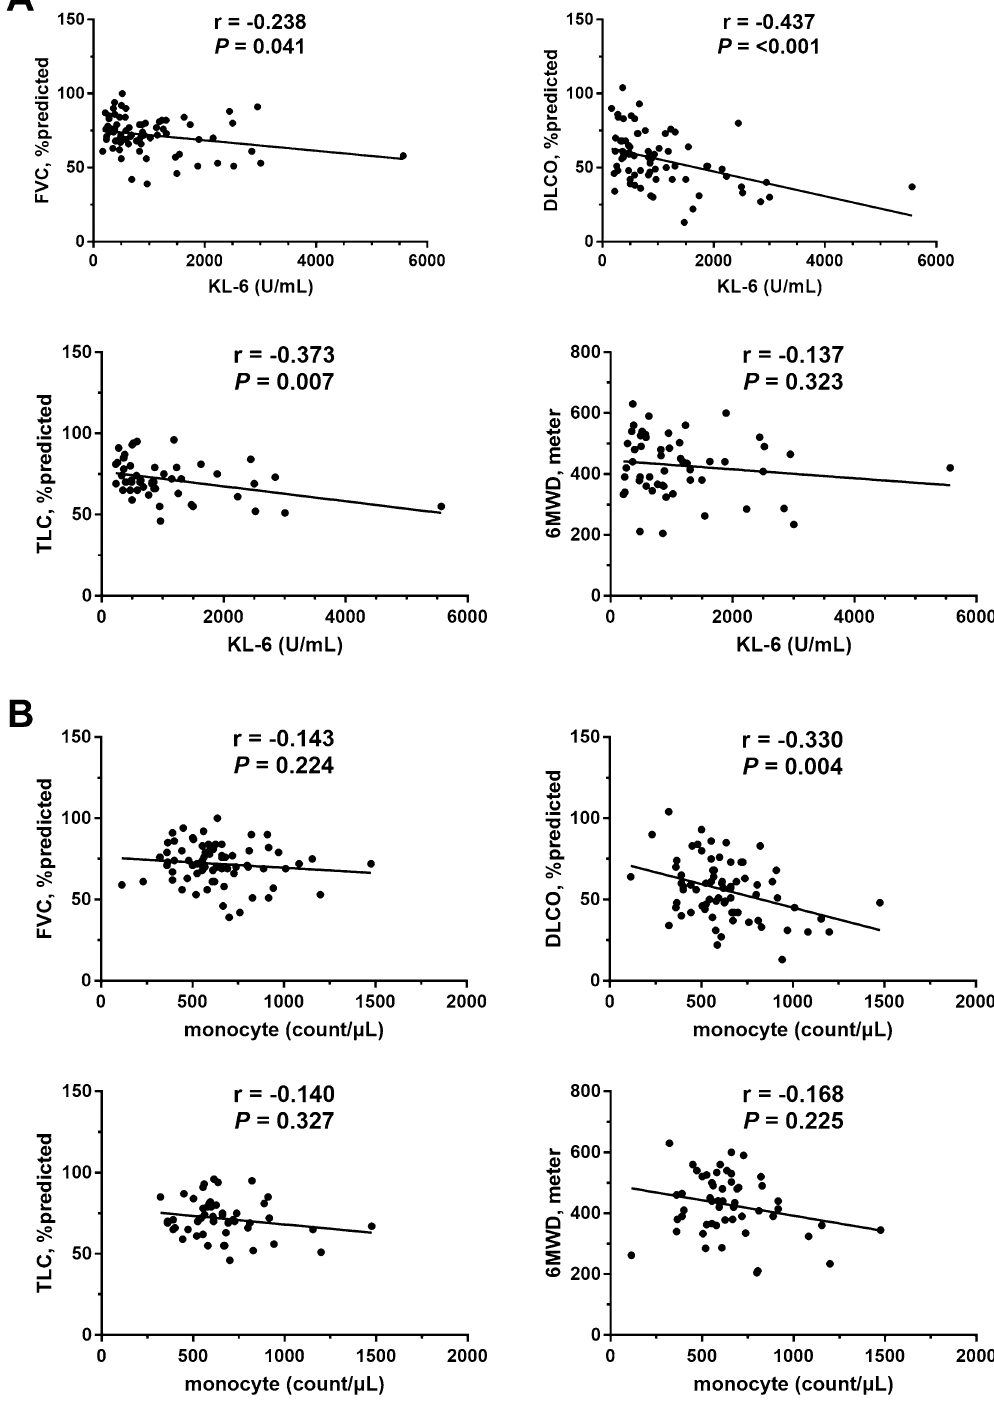
Figure 1. Correlation between baseline biomarkers and lung function or exercise capacity. ( A ) KL-6, ( B ) monocyte. KL-6: Krebs von den Lungen-6, FVC: Forced vital capacity, DLco: Diffusing capacity of the lung for carbon monoxide, TLC: Total lung capacity, 6MWD: 6-min walk test